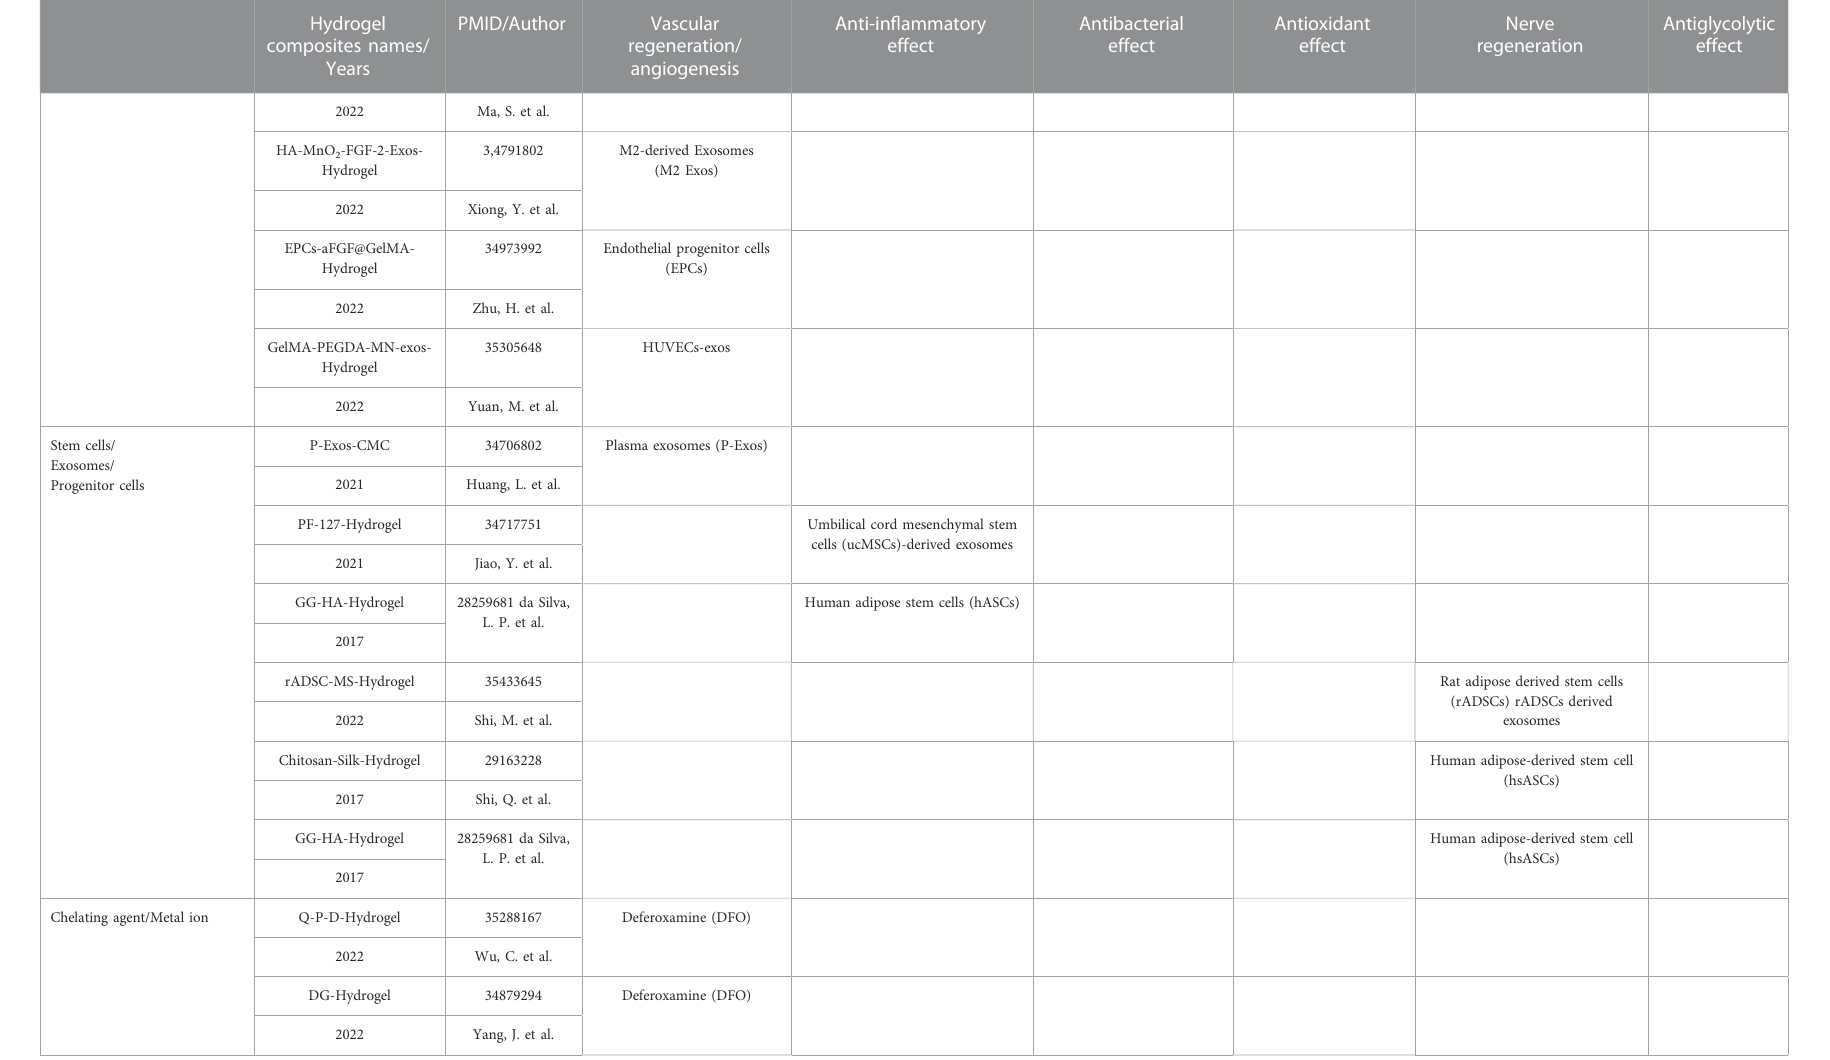
TABLE 1 ( Continued ) Classi fi cation of loading components in composite hydrogels in the treatment of chronic diabetic